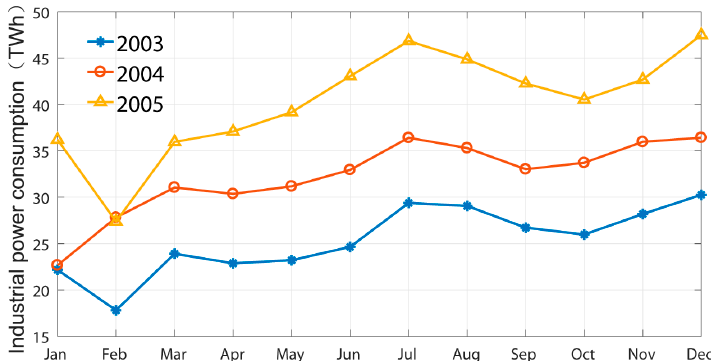
Figure 1. Industrial power consumption of